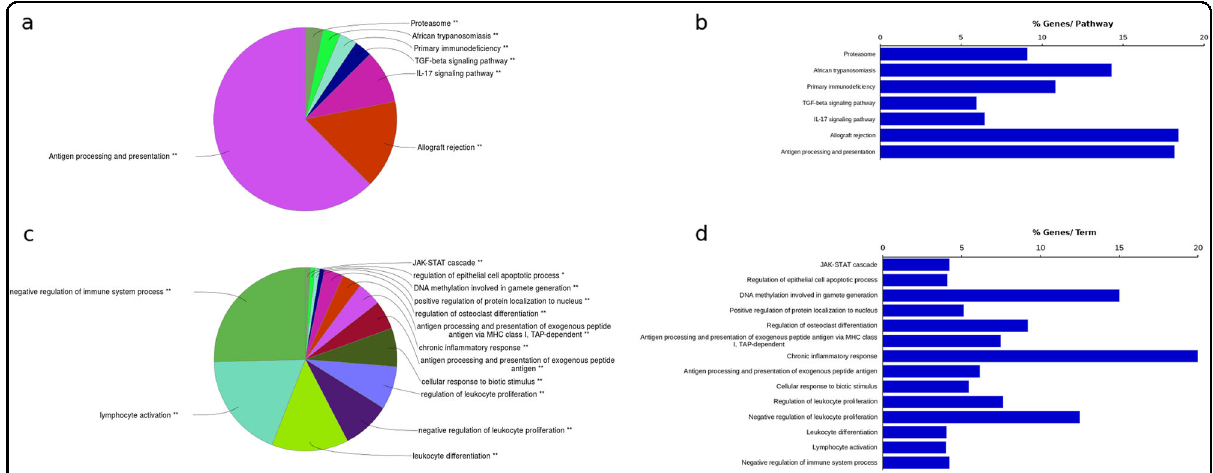
Fig. 1 The guilt-by-association analysis of 47 IBD lncRNAs was performed by retrieving protein-coding genes (100 kb up/downstream) in the vicinity of these lncRNAs. One hundred ninety-three protein-coding genes were retrieved and used for gene ontology and pathway-based clustering using ClueGO in CytoScape. a shows the most signi fi cant biological process (BP) categories and c shows the most signi fi cant pathways based on KEGG annotations associated with the protein-coding genes. b , d Only the representative terms for each cluster as selected by ClueGo analysis based on the total number of genes and %Genes/Term are reported. The total number of genes and %Genes/Term are listed next to the representative term. The P values for each group are denoted by * P value < 0.05) and ** P value <